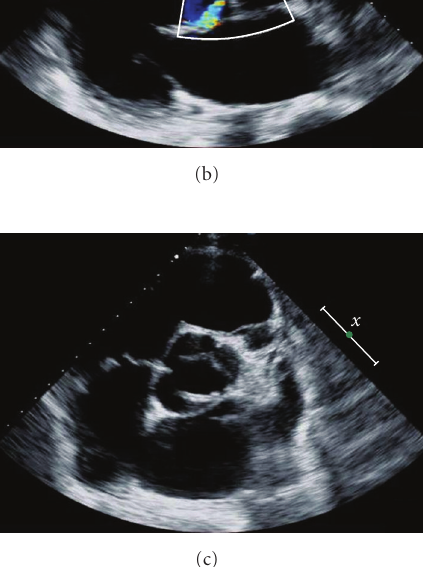
Figure 1: Transthoracic echocardiography. (a) Parasternal long- axis view, the left ventricule telediastolic diameter is 80 mm. (b) Parasternal long-axis view, aortic regurgitation. (c) Short-axis view at the level of the aorta, bicuspid aorti valve.